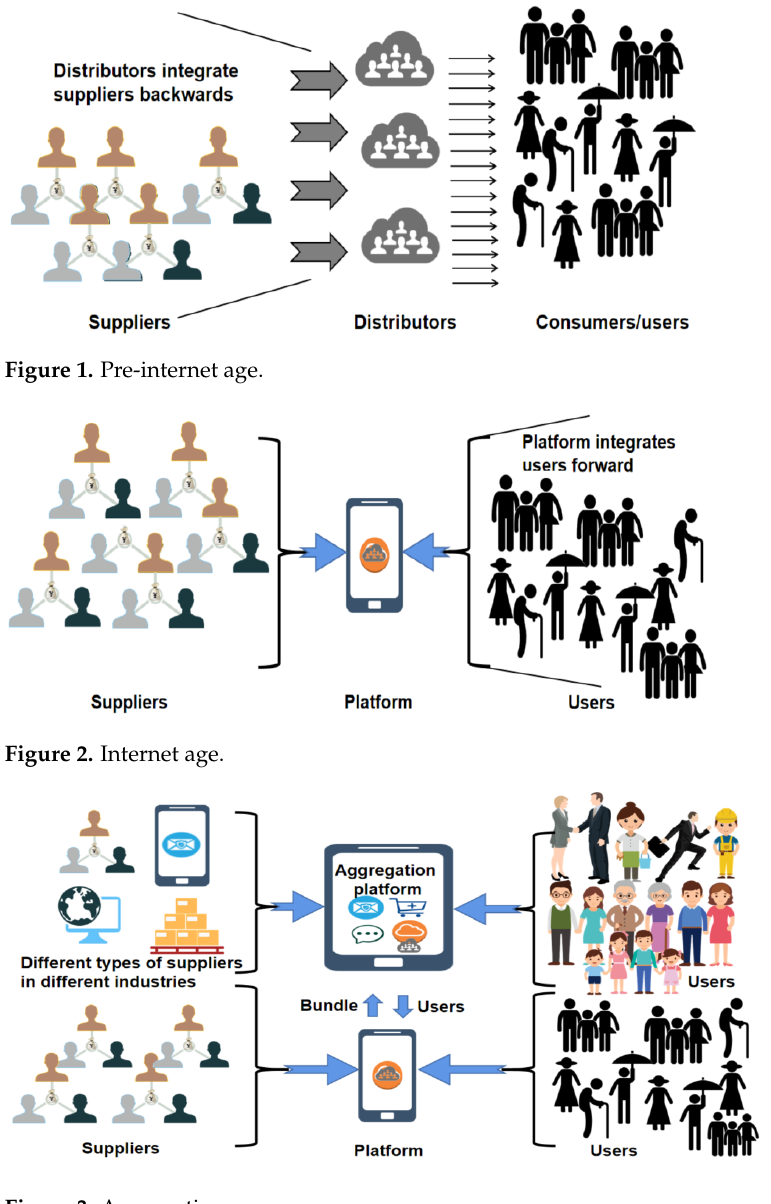
Figure 3. Aggregation